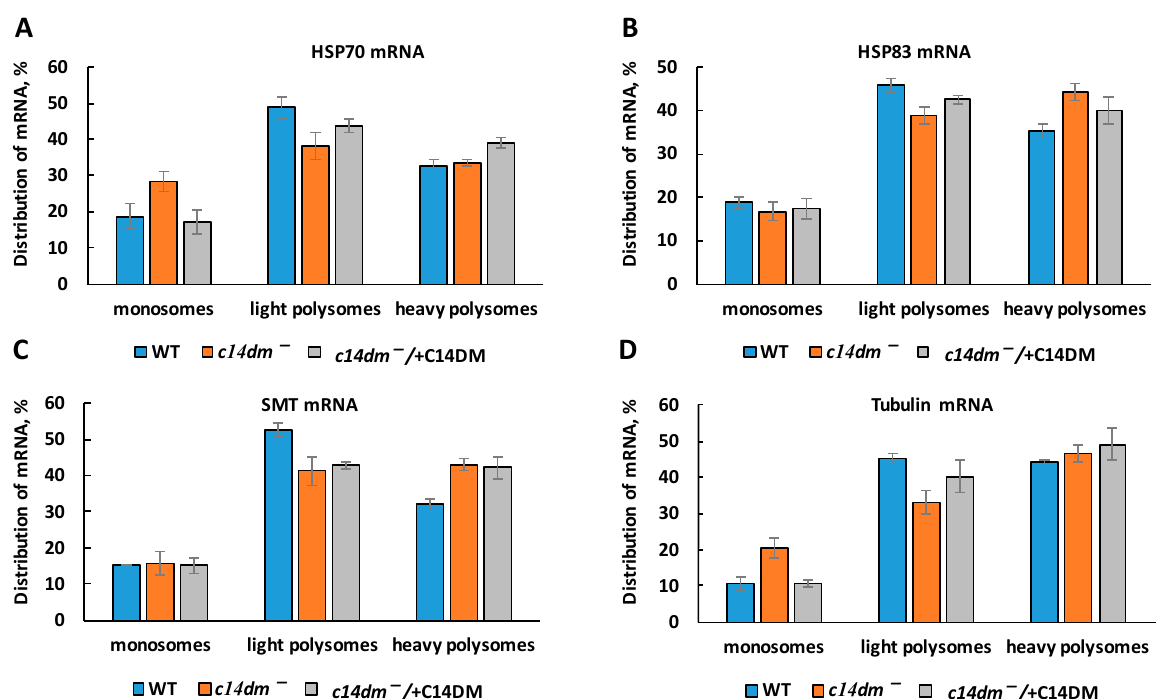
Figure 8. The association of individual mRNAs with monosomes and light and heavy polysomes is largely unaffected in c14dm − mutant. Distribution of HSP70 ( A ), HSP83 ( B ), SMT ( C ) and tubulin ( D ) mRNAs among monosomes, light polysomes and heavy polysomes was determined by RT-qPCR after RNA extraction from polysomal fractions.